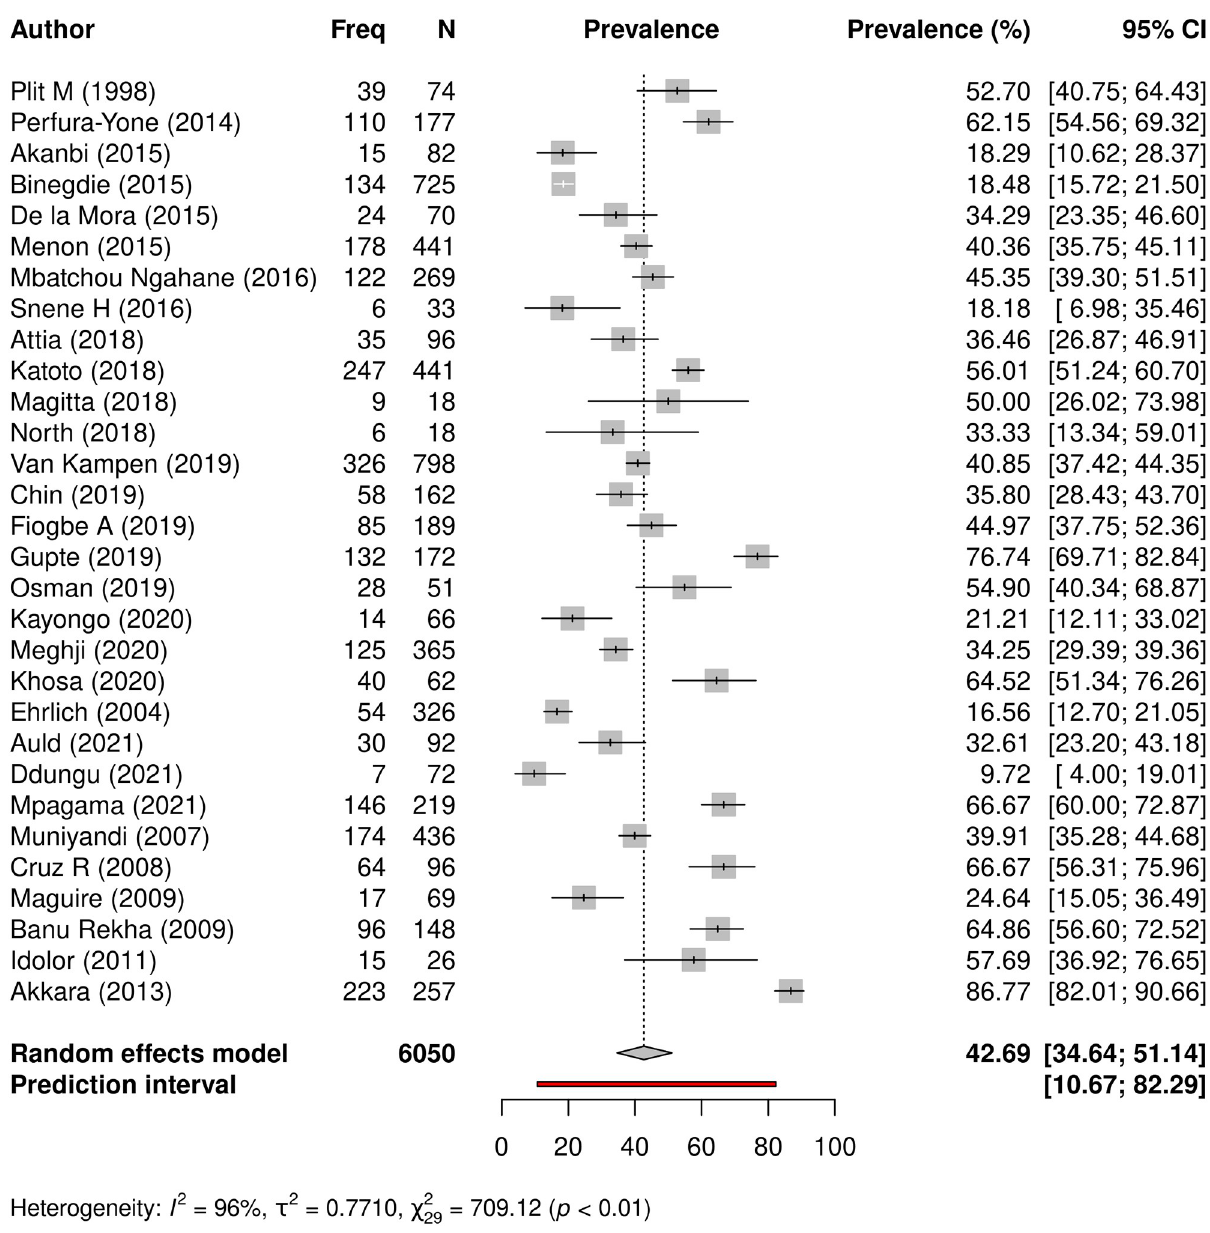
Fig 5. Overall prevalence of PTLD. A forest plot showing the overall prevalence of PTLD from all 30 studies involving a pooled sample size of 6050 study participants. Studies used varying methods of post-TB assessment, for this composite model if a study used more than one method, spirometry data was adopted, symptom data if no spirometry was done, and radiology data if neither spirometry nor symptom assessment was